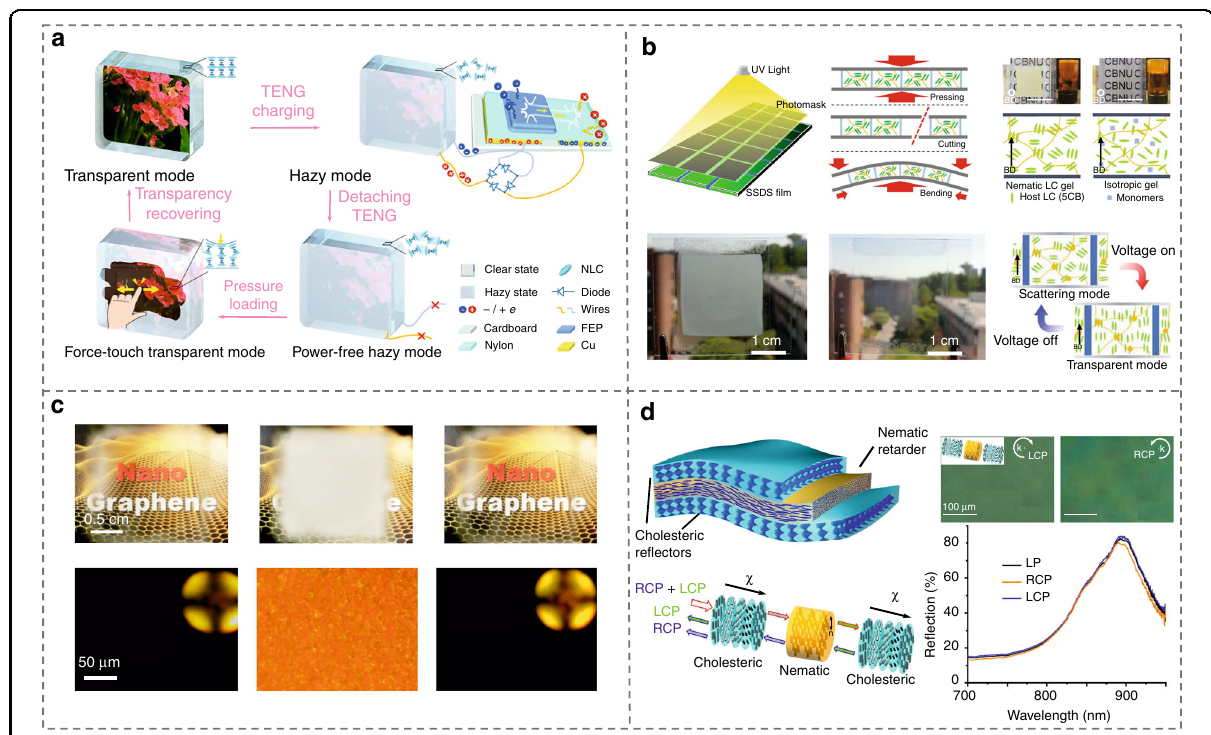
Fig. 16 Smart window applications. a A self-powered hybrid switchable solar window based on CLCs and a sliding triboelectric nanogenerator 279 . Adapted from ref. 279 , with permission from Elsevier. b Robust LC smart windows with low voltage switching 283 . Reproduced from ref. 283 , with permission from Wiley-VCH. c Smart windows based on LC/graphene composites 285 . Reproduced from ref. 285 , with permission from Elsevier. d CNC- based tunable photonic re fl ectors 287 . Adapted with permission from ref. 287 . Copyright 2018 American Chemical